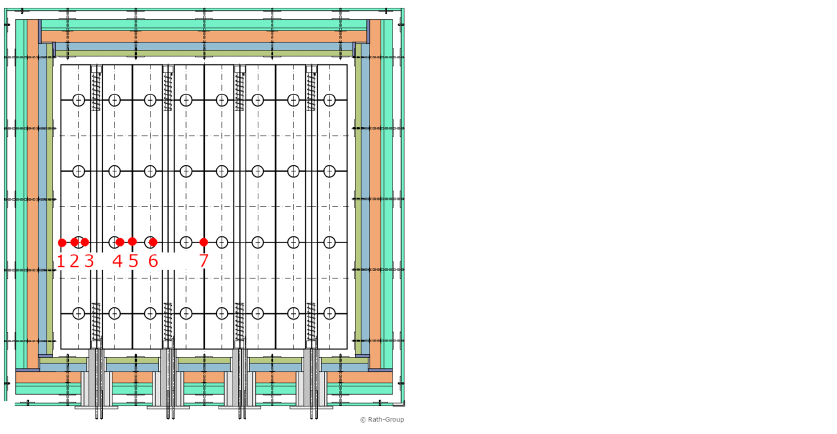
Figure 10. Location of measurement points (highlighted in green) for comparison with simulation variables.